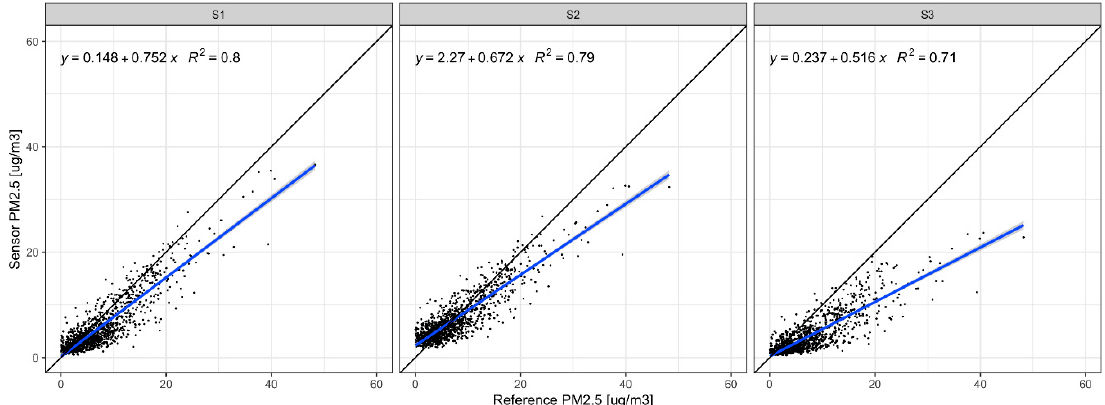
Figure 10. Linear regression for 1-hour average PM 2.5 values for environmental condition with RH < 80% from the three SDS011 sensors versus the PM 2.5 data from the air quality monitoring station for the entire study period.